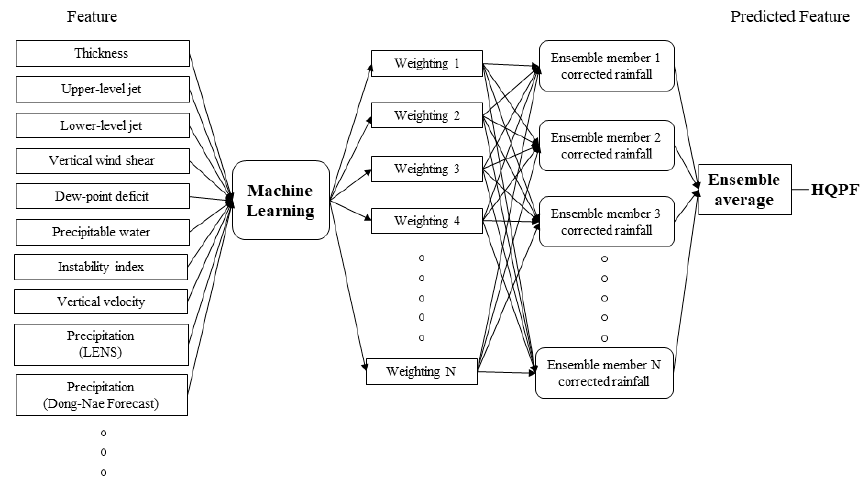
Figure 2. Mimetic diagram for machine learning training.